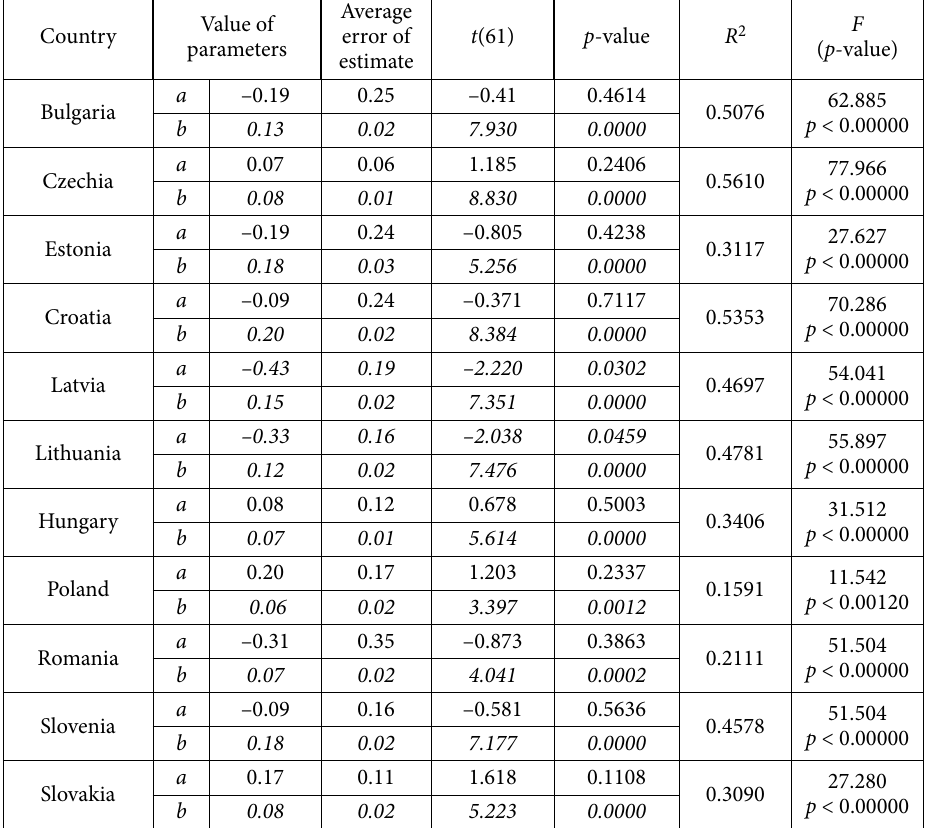
Table 5. Results of the estimation and verification of